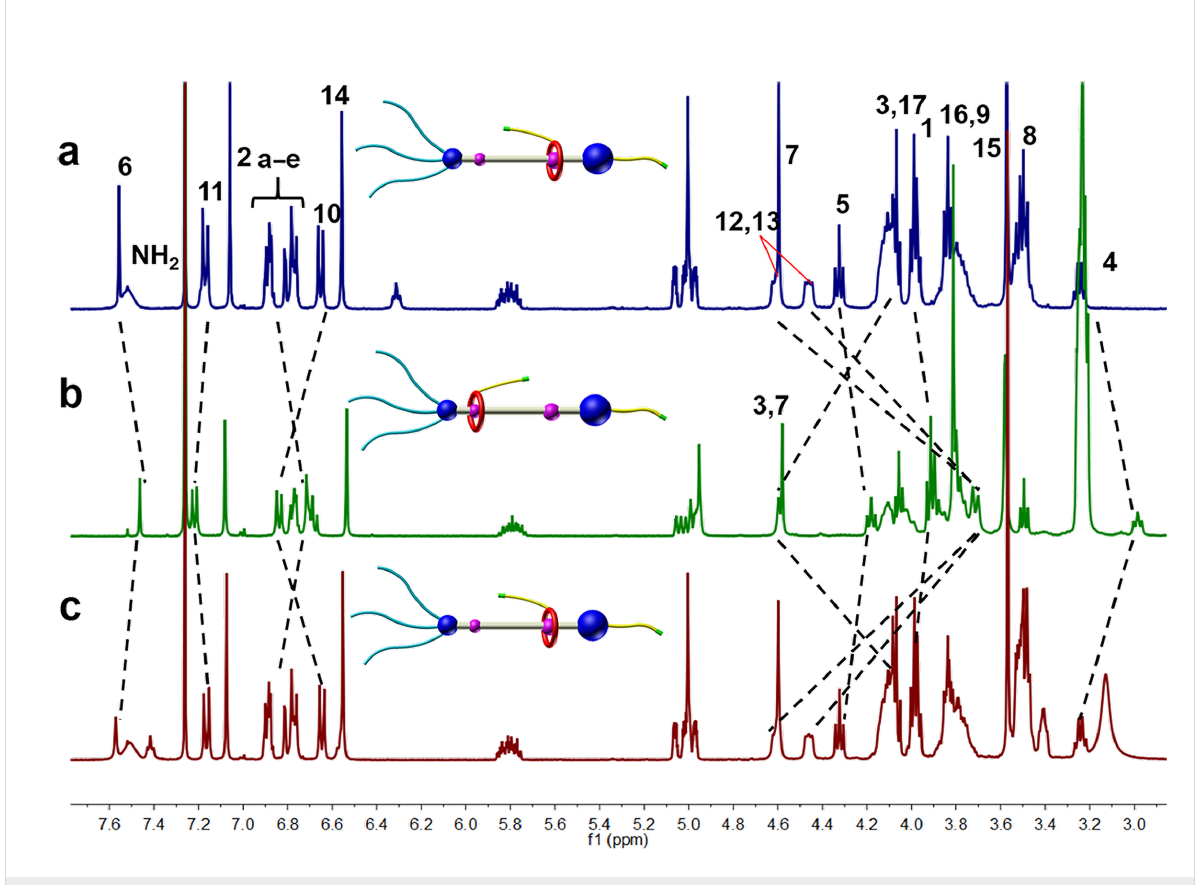
Figure 2: Partial 1 H NMR spectra (400 MHz, CDCl 3 , 298 K). (a) [2]Rotaxane R1 , (b) deprotonation by the addition of 2.0 equiv of DBU to (a), (c) reprotonation with addition of 3.0 equiv of TFA to (b).